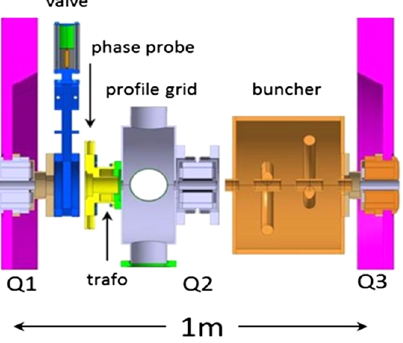
FIG. 2. Intercavity section located between two regular lattice sections.